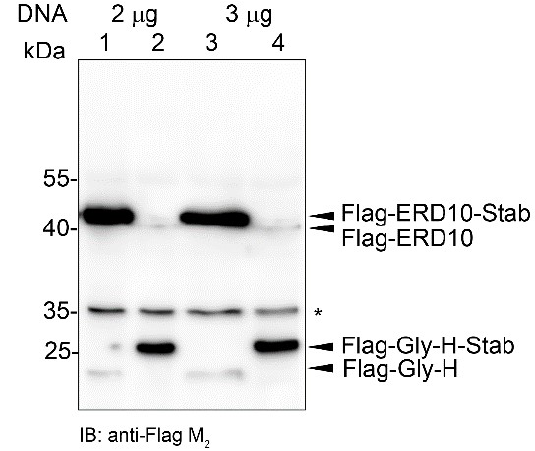
Figure 7. STABILON fusion is the prerequisite for efficient transgene expression in non-induced transiently transfected CHO-K1 cells. CHO-K1 cells transiently transfected with a mixture of Flag- Gly-H and Flag-ERD10-Stab (lane 1 (2 µ g DNA from each), lane 3 (3 µ g DNA from each)) or Flag-Gly- H-Stab and Flag-ERD10 (lane 2 (2 µ g DNA from each), lane 4 (3 µ g DNA from each)), respectively, were analyzed by immunoblotting 20 h post-transfection. Non-specific band (marked by asterisk) serves as loading control.